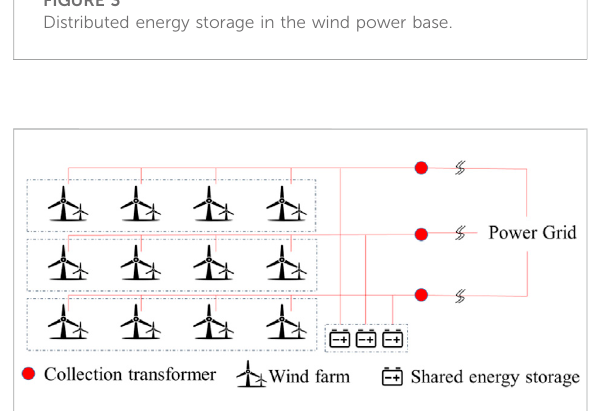
FIGURE 4 Shared energy storage in the wind power